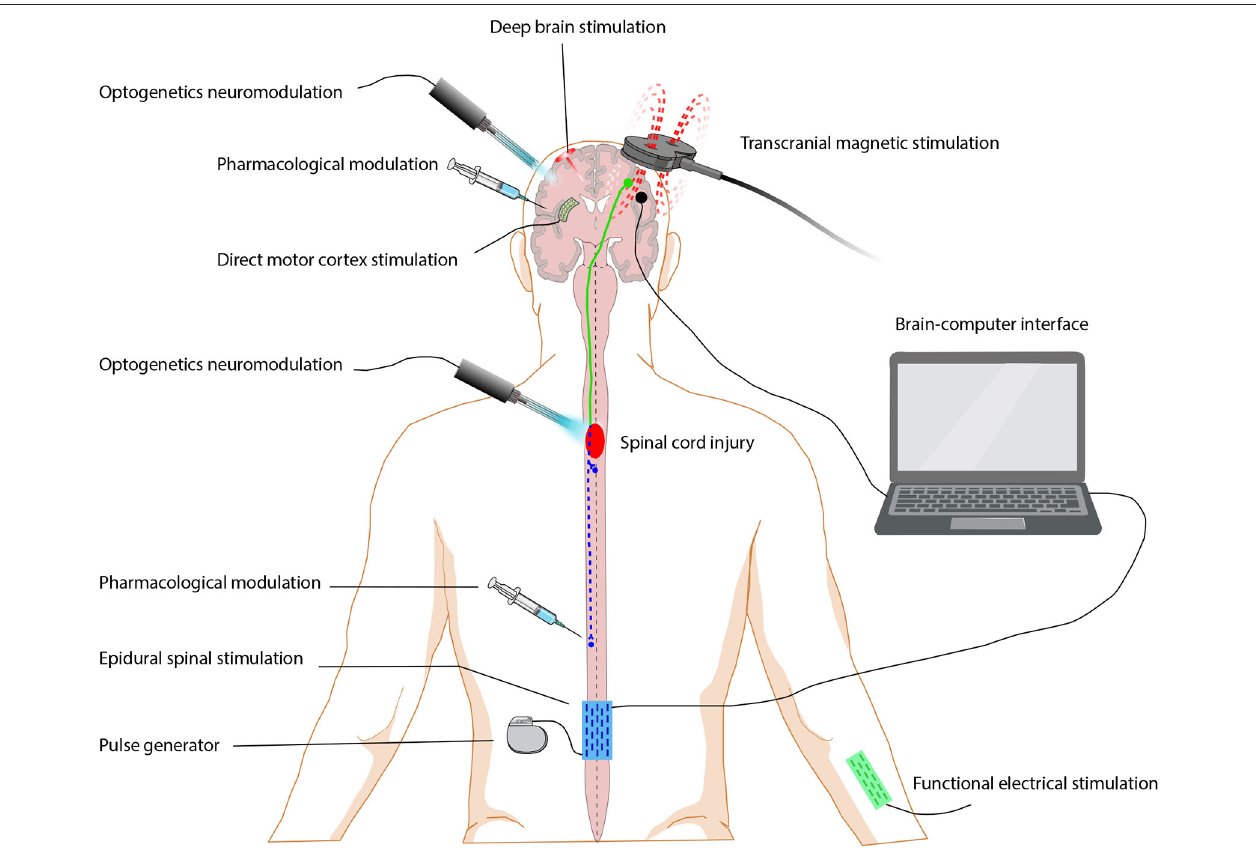
FIGURE 1 | Neuromodulation approaches for restoring function after spinal cord injury. Neuromodulation includes pharmacological modulation, electrical modulation and optogenetics modulation. Electrical modulation approaches are grouped by the stimulation location, including brain stimulation (deep brain stimulation, direct motor cortex stimulation), spinal cord stimulation (epidural electrical stimulation), peripheral stimulation (functional electrical stimulation) and brain-machine